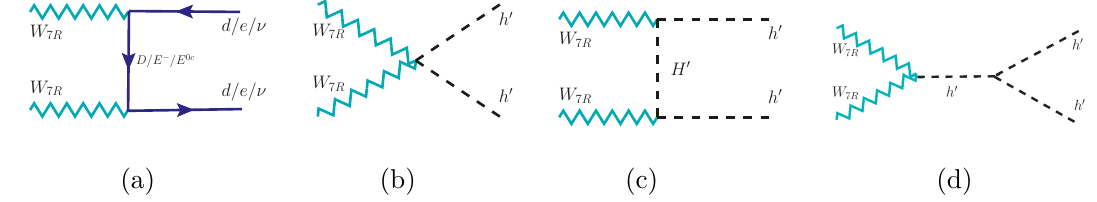
Figure 5 . Relevant Feynman diagrams that contribute to vector boson DM annihilation.